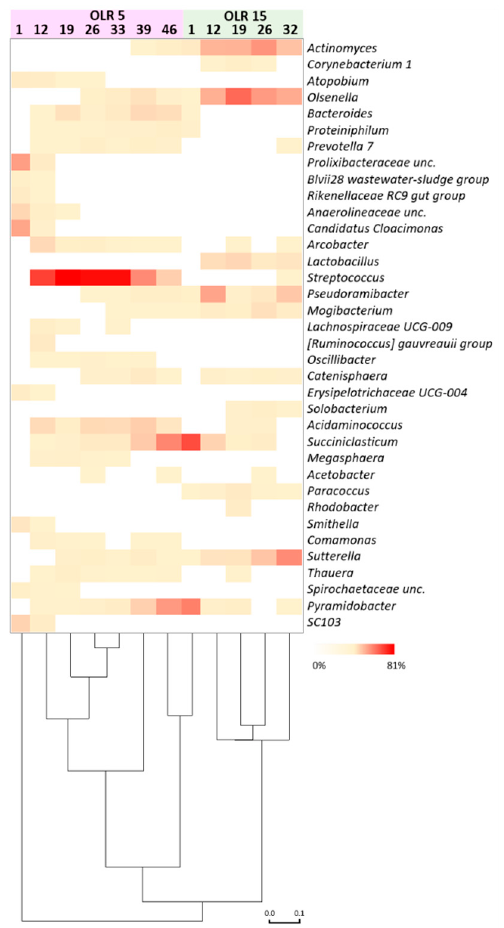
Figure 3. Relative abundance of microbial genera ( ≥ 1% in at least one sample) during the reactors operation. Bray Curtis statistics was used for clustering the samples according to the process pa- rameters.